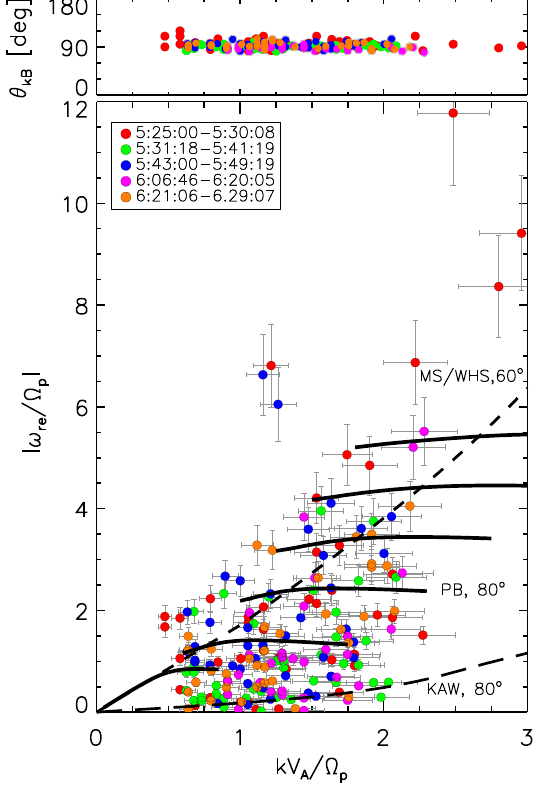
Figure 4: Frequency-wave number diagram. The angle (cid:18) kB between determined wave vectors and the background magnetic (cid:28)eld is shown in the top panel indicating the quasi-perpendicular wave vector characteristic. The lower panel shows the distribution of the observed dispersion relations as well as linear theory dispersion relations for the magnetosonic-whistler (MS/WHS) and proton Bernstein (PB, solid) modes at (cid:18) = 80 (cid:14) , the MS/WHS waves at (cid:18) = 60 (cid:14) (dashed line), and the kinetic AlfvØn waves (KAW, long dashed line) at (cid:18) = 80 (cid:14) . Errorbars are plotted in light gray.